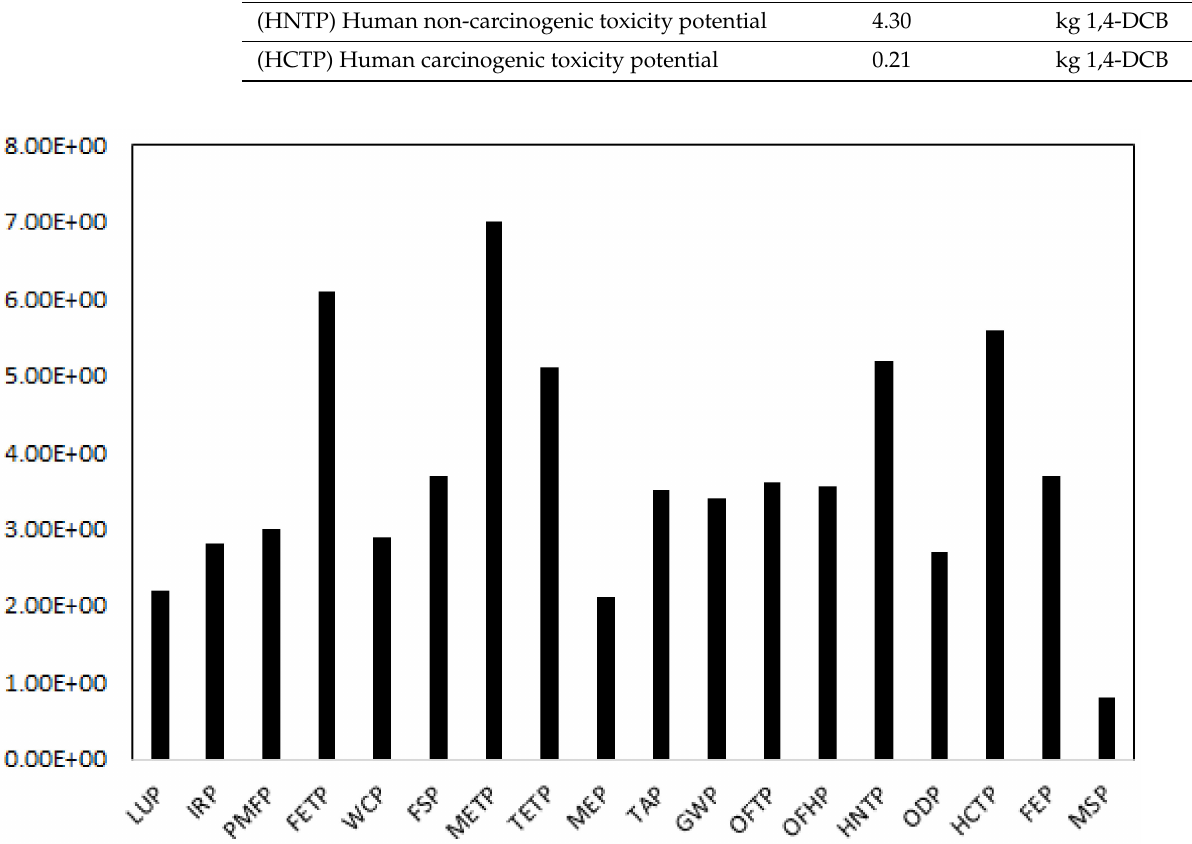
Figure 7. Normalized ReCiPe Midpoint (H) impact categories for AC production from waste leaves of Quercus alba (FU: 1